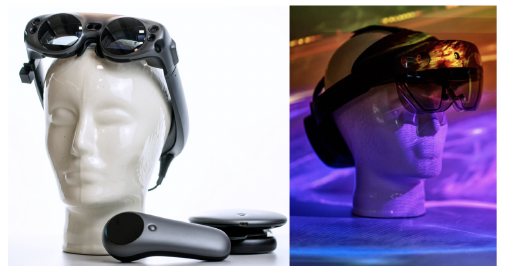
Figure 4. Magic Leap ( left ) and HoloLens 2 ( right